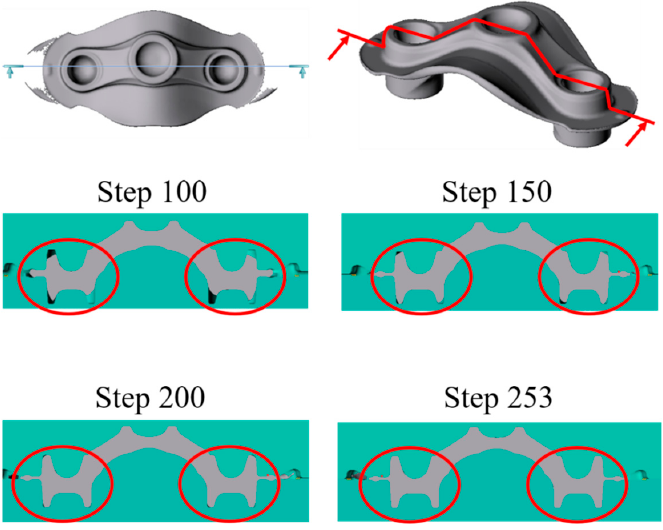
Figure 9. FEM simulation on forming and filling analysis of crown forgings.